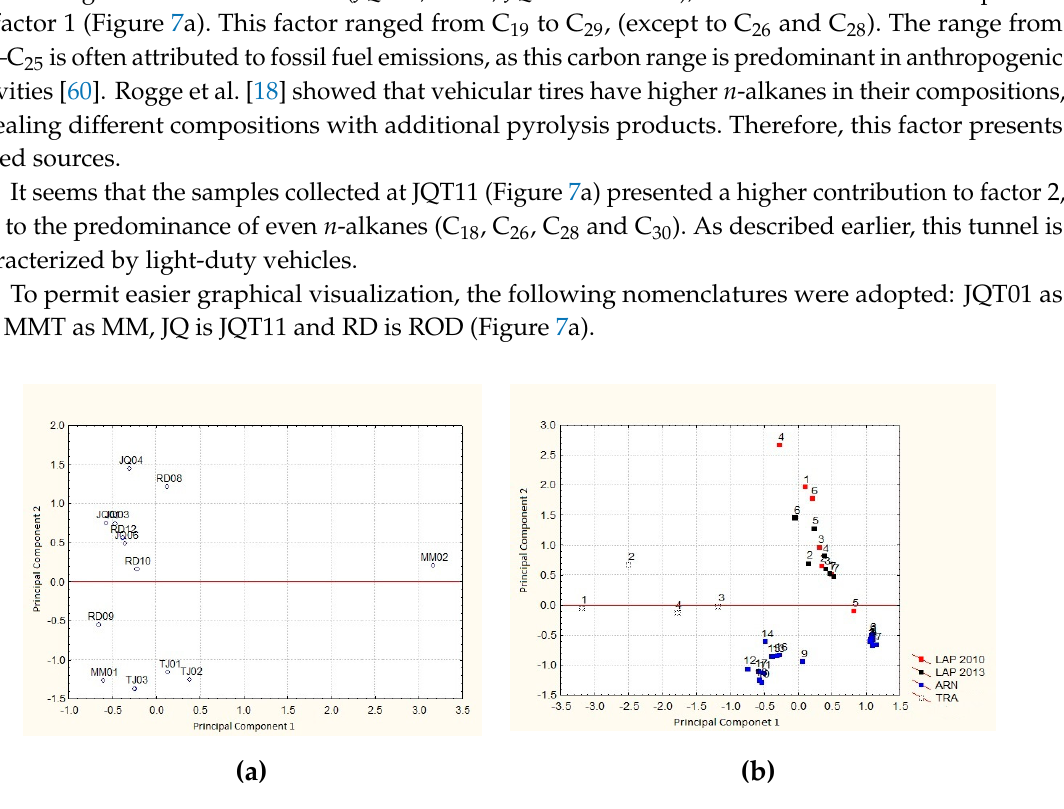
Figure 7. Score graphs of the two principal components for each site with ( a ) large concentrations and ( b ) small concentrations.